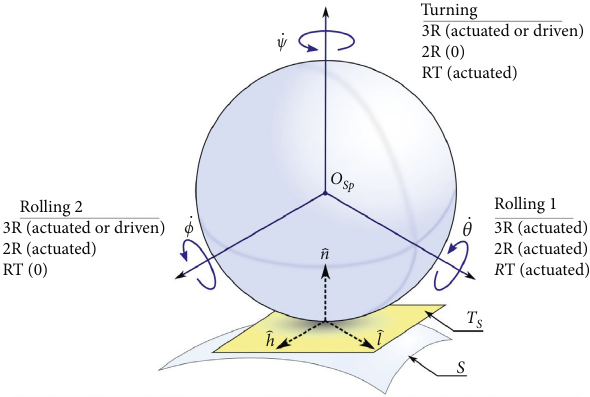
Figure 3: Schematic diagram of rotation directions of continuous rolling spherical robots.